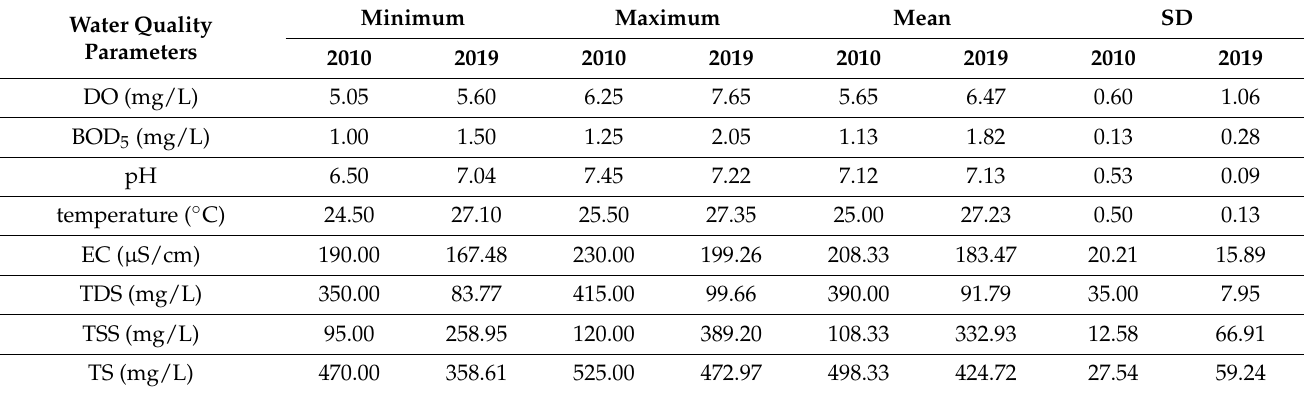
Table 4. Descriptive statistics of the WQPs.